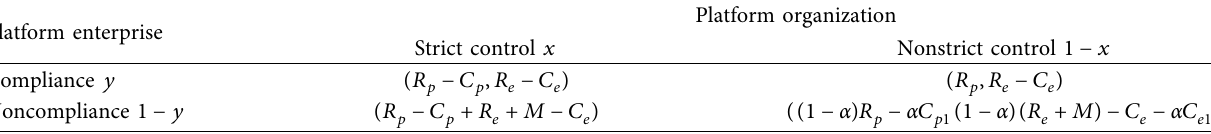
Table 1: Te beneft matrix of game revenue between the platform organization and platform enterprise based on laborer supervision. Platform